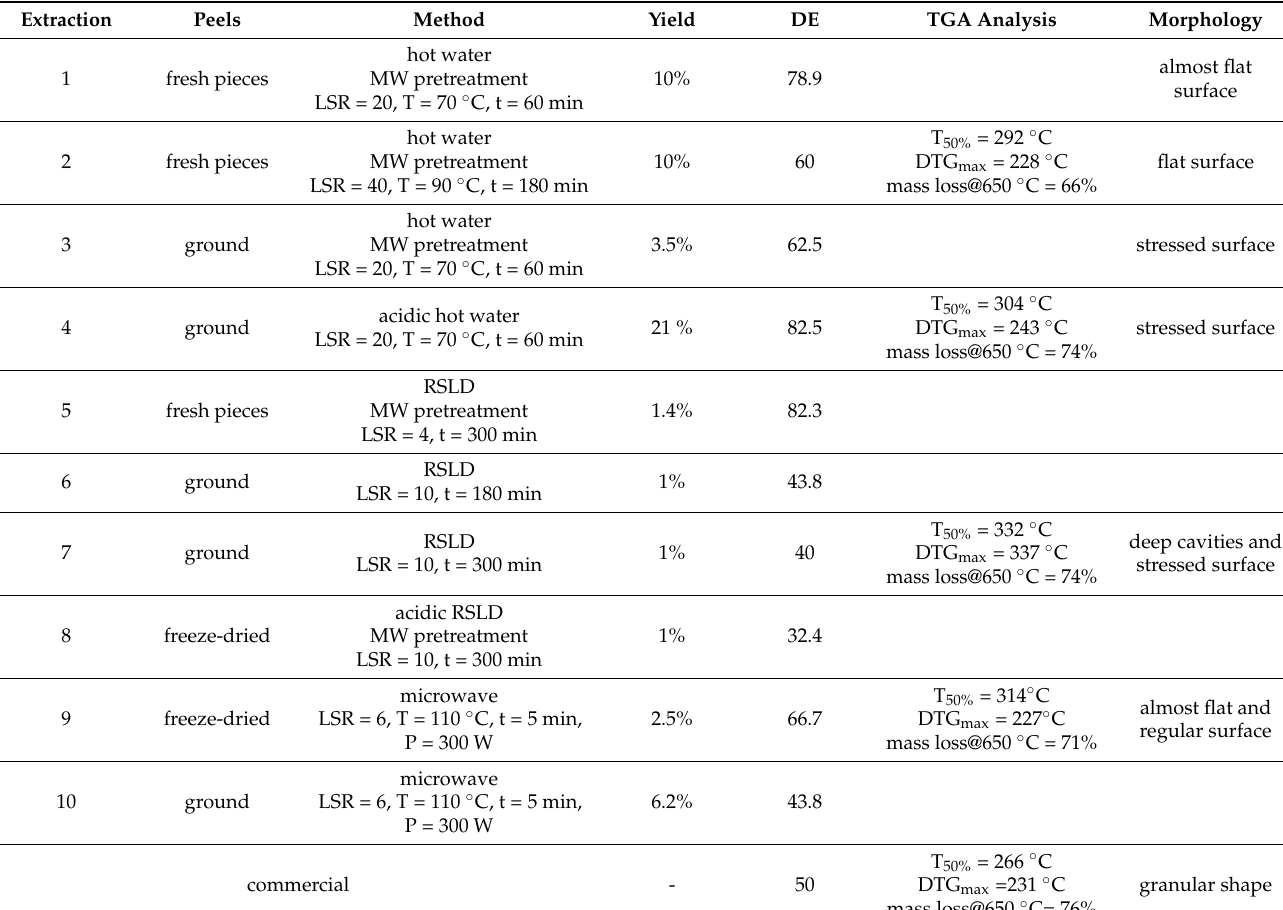
Table 1. Comparison between different extraction protocols, in terms of experimental steps, extraction yield, esterification degree, thermogravimetric properties and morphology of extracted